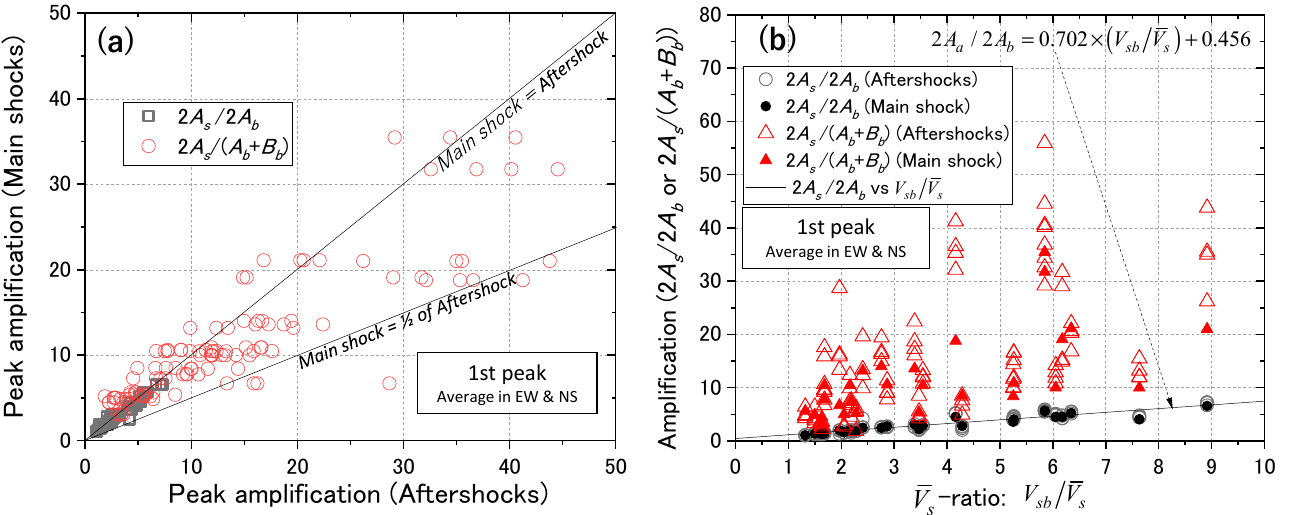
Figure 13. Comparison of first peak amplification values between mainshocks versus corresponding aftershocks ( a ), and Peak amplification versus 𝑉(cid:3364) (cid:3046) -ratio for mainshocks and aftershocks ( b ).